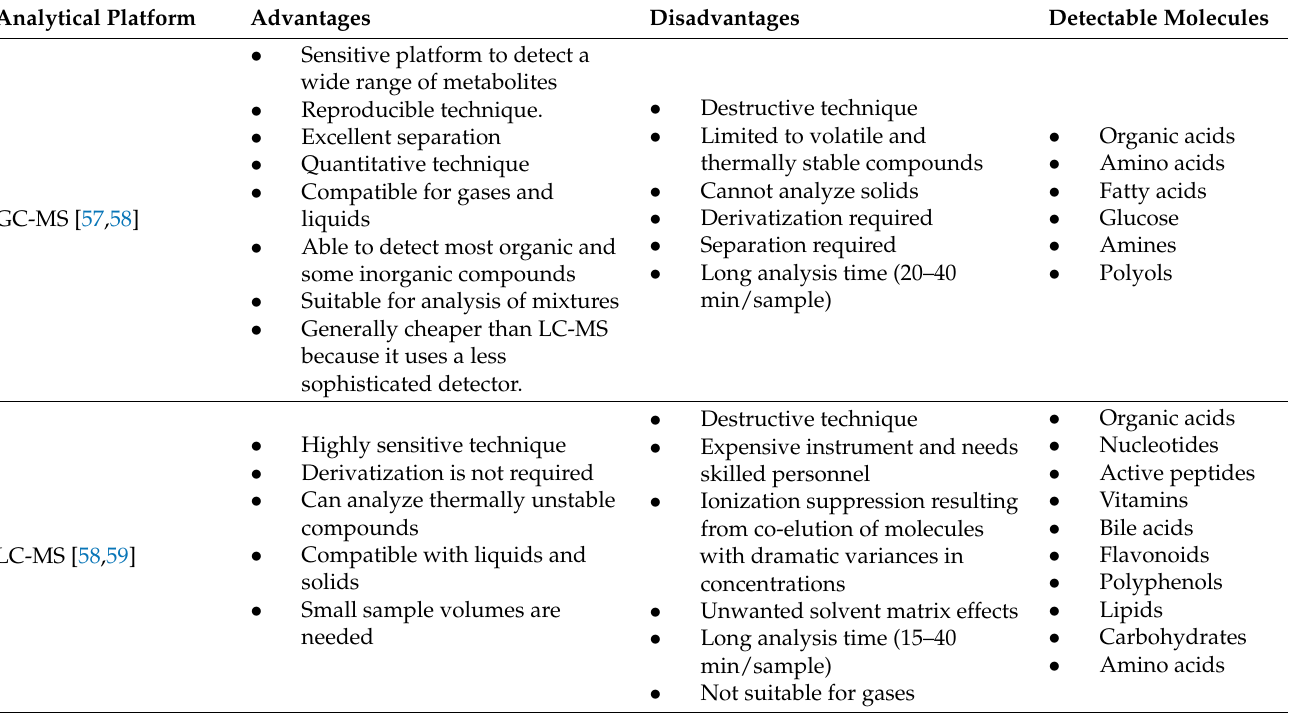
Table 5. Comparison between different analytical